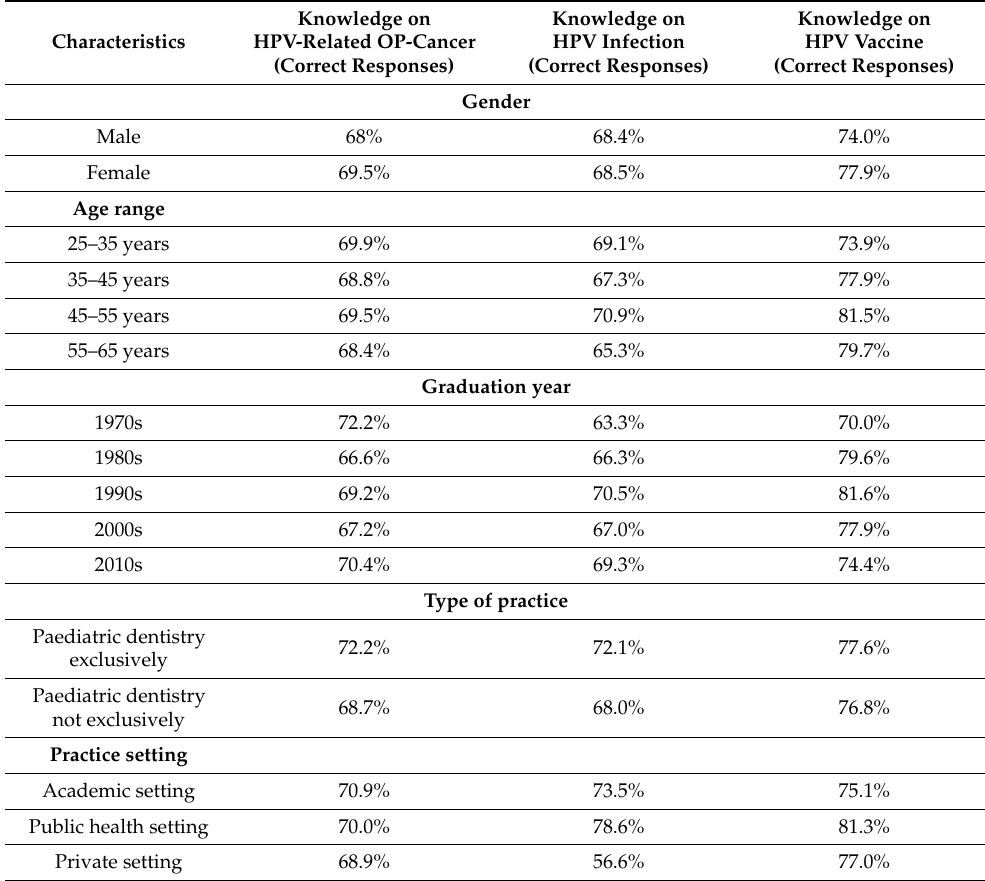
Table 2. Percentages of correct responses on knowledge on HPV-related OP-cancer, HPV infection, and HPV vaccine, according to gender, age range, graduation year, type of practice, and practice